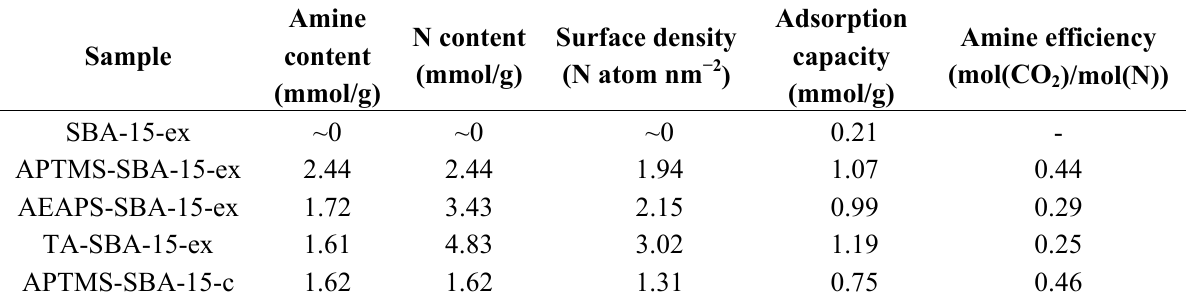
Table 2. The amine content and the adsorption properties of the adsorbents.